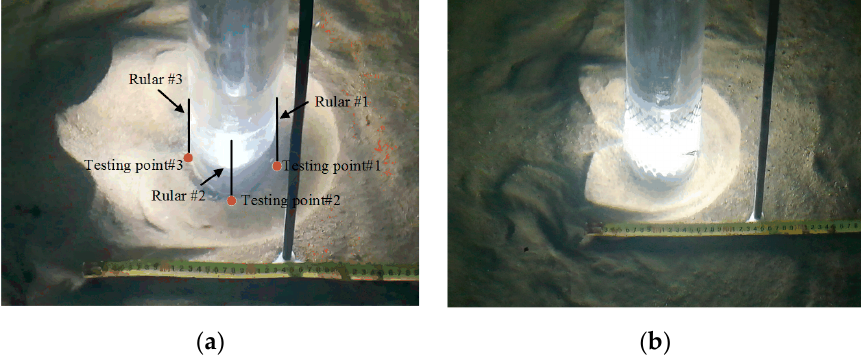
Figure 19. Scour pit: ( a ) before using the fishnet device; ( b ) after using the fishnet device.